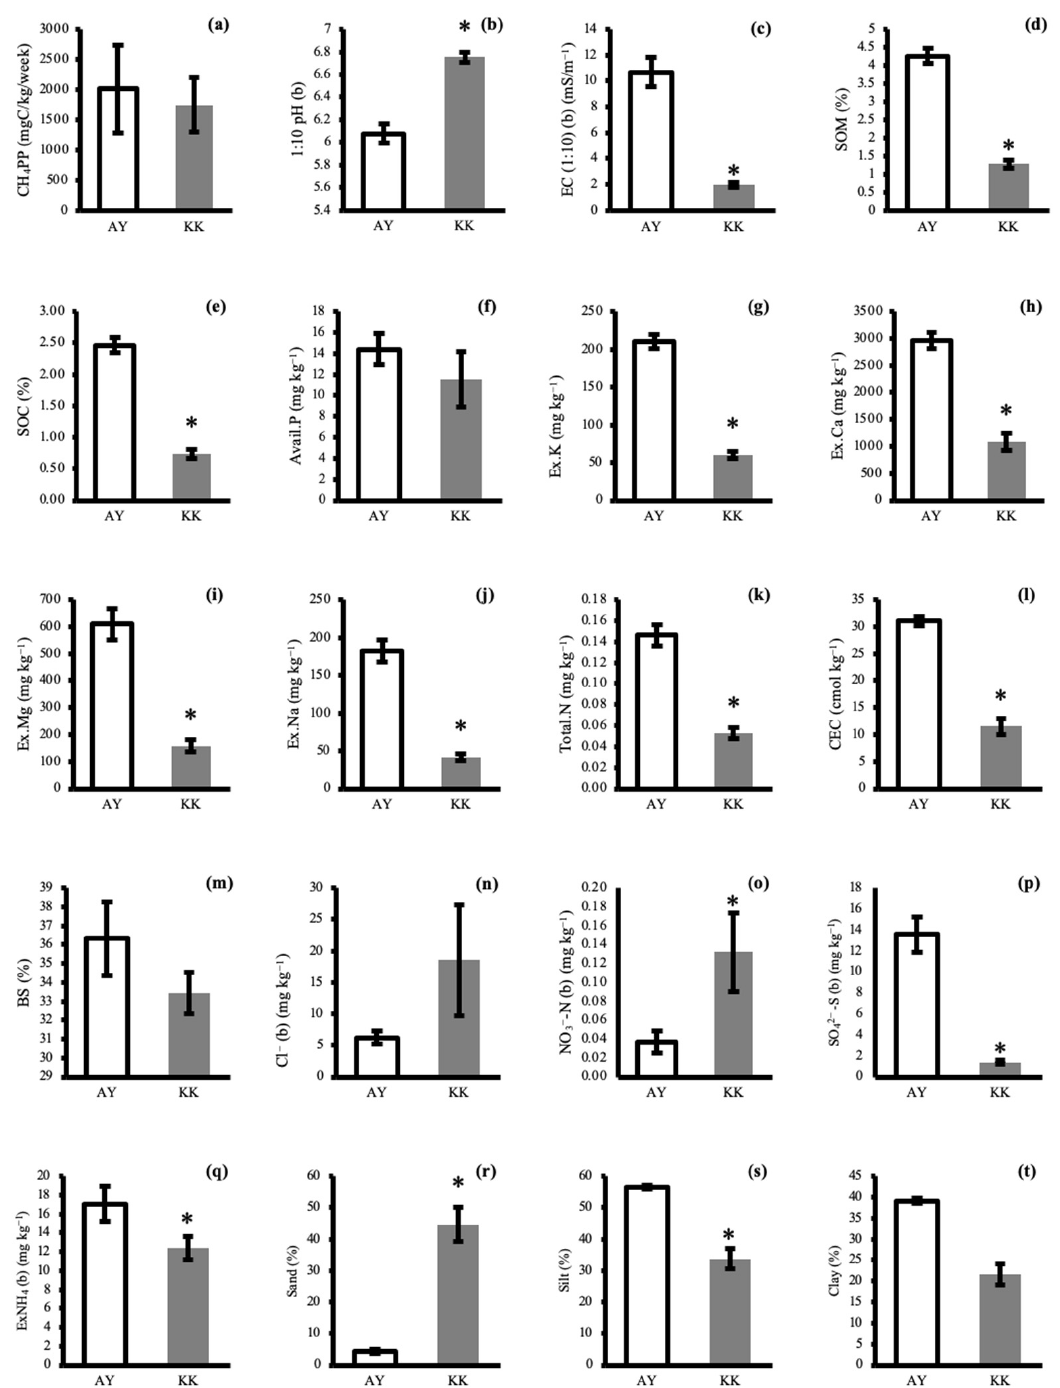
Figure 4. A comparison of average differences in CH 4 production potential and soil properties before incubation in Ayutthaya and Khonkaen. CH 4 PP = CH 4 production potential ( a ); 1:10 pH(b) ( b ); 1:10 EC(b) = 1:10 electronic conductivity ( c ); SOM = Soil organic matter ( d ); SOC = Soil organic carbon ( e ); Avail.P = Available phosphorus ( f ); Ex.K = exchangeable potassium ( g ); Ex.Ca = Exchangeable calcium ( h ); Ex.Mg = Exchangeable magnesium ( i ); Ex.Na = Exchangeable sodium ( j ); Total.N = Total nitrogen ( k ); CEC = Cations exchange capacity ( l ); BS = Base saturation ( m ); Cl − = Chloride ( n ); NO 3 − -N = Nitrate ( o ); SO 4 2 − -S = Sulfate ( p ); ExNH 4 = Exchangeable ammonium ( q ); Sand(%) ( r ); Silt(%) ( s ); Clay(%) ( t ). Asterisk (*) represents a significant difference at the p < 0.05 level between the 2 areas. PO 4 3 − -P is not shown.